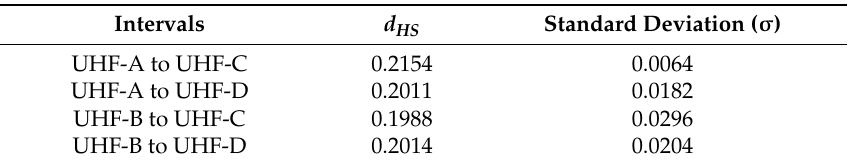
Table 2. d HS values of the intervals across the L-branch.